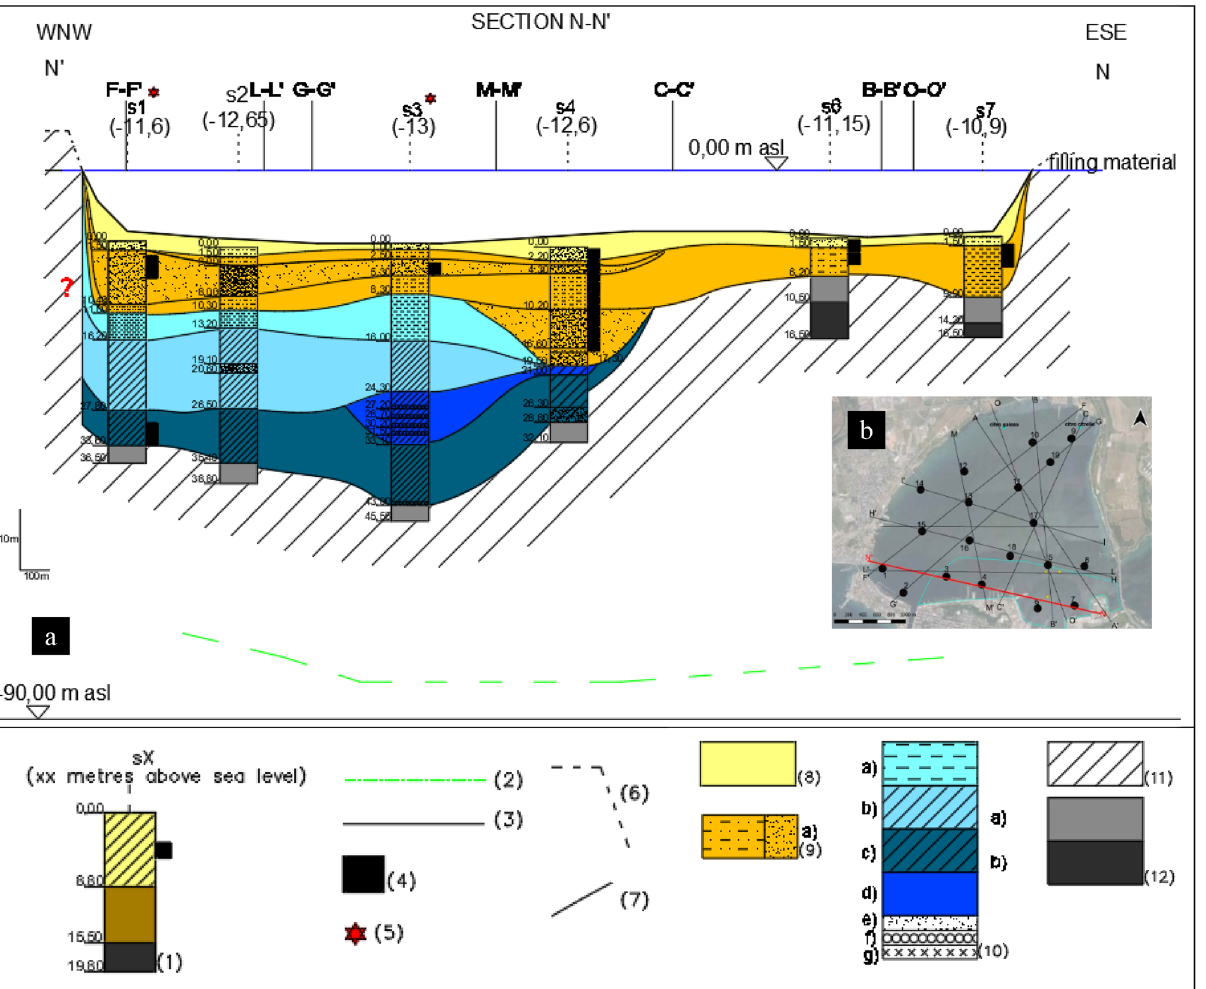
Figure 7. ( a ) Litho-technical section N–N ′ ; ( b ) I Bay and location of all the investigated sections. Key: (1) 2017 campaign projected borehole; (2) top of the calcareous bedrock according to 30 (3) bathymetry (Port authority 1947–1978); (4) significant content of organic matter; (5) fishing net (anthropogenic material); (6) coastline; (7) stratigraphic contact; (8) 1stLTU ; (9) 2ndLTU , of consistency from very soft to soft and occasional presence of sand or silty sand, from very loose to loose ( a ); (10) 3 rd LTU , of consistency increasing with depth, from very soft to soft ( a ), from soft to firm ( b ), firm ( c ), stiff ( d ) 66,67 , and occasional layers rich in sand ( e ), gravel ( f ) and peaty levels ( g ); (11) Possible disturbed top layers of the ASP formation; (12) ASP formation, with clayey silt or silty clay of very stiff consistency, and sandy levels (S u = 200–500 kPa) ( a ), or Grey-bluish marly-silty clay (S u > 500 kPa) ( b (Fig. 8), except for the sand layer interbedded in this unit in the western part of section N–N ′ (SF = 52.8–79.8%; Fig. 8). For this sand level, from medium-dense to loose, an average K = 10 –6 m/s has been measured by means of permeameter testing 85 . According to both the paleo-geographic and the sedimentological analyses, also the 2nd LTU sediments, slightly coarser than the 1 st LTU sediments, are either present day or recent and derive from the erosion of calcarenites and parent coastal-alluvial, or marine formations in-land. At larger depths, several boreholes cross a Third litho-technical unit, hereafter 3rd LTU (light to dark blue colours in Fig. 7a). This is formed of silt, clayey silt or silty clays (Fig. 8), including local sandier levels, gravel levels and peat. It is of lower permeability than the overlaying units (K = 10 –9 –5 × 10 –10 m/s) and includes differ- ent sub-units. The lower portion of the 3rd LTU is interpreted to be the result of a high energy fluvial deposi- tion, most probably occurred during the Last Glacial Maximum (33–14 ka) 86 . Above the fluvial sediments, the recognition of levels of peat with pulmonated gastropods suggests that part of this unit was deposited within a transient continental environment, most likely at the beginning of the Holocene (11–10 ka). This part of the 3rd LTU passes gradually to upper silts and clays containing lagoonal shells, which mark the beginning of the marine transgression, within a sheltered marine environment. About 9 ka years ago, this sheltered marine basin was affected by the fall of volcanic ashes, deriving from the Pomici di Mercato eruption of Vesuvius. As a result of such event, a whitish porous tephra layer, 5 to 40 cm thick, is found to occur locally within this unit, at about 19–21 m depth, as confirmed by the results of PXRF analyses discussed later.